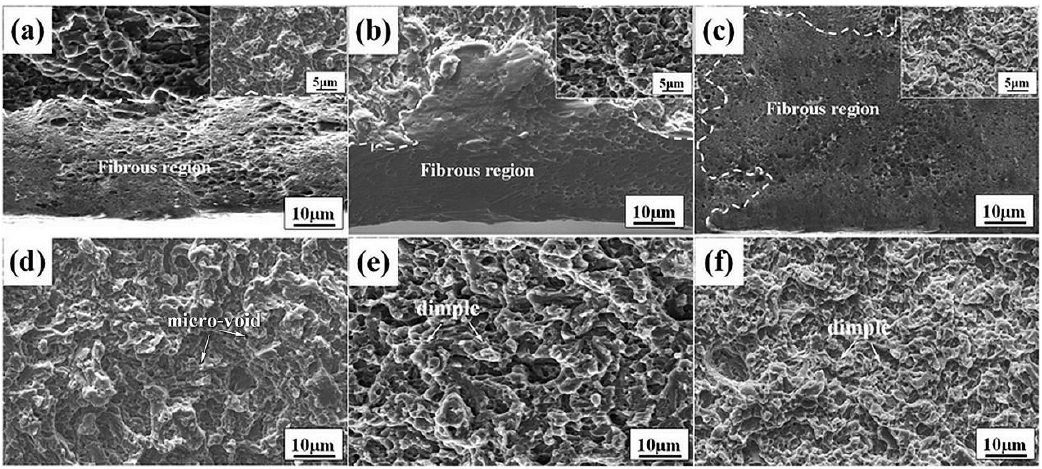
Figure 10. The fractographies of the Q-T specimen and austempered specimen without and with CR: ( a – c ) the fibrous region; ( d – f ) the crack propagation region.